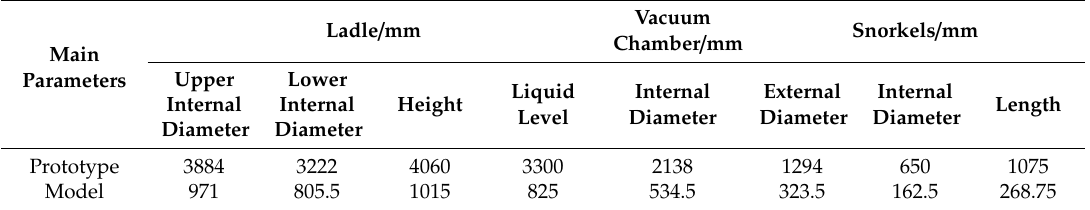
Table 1. Characteristic parameters of industrial and model